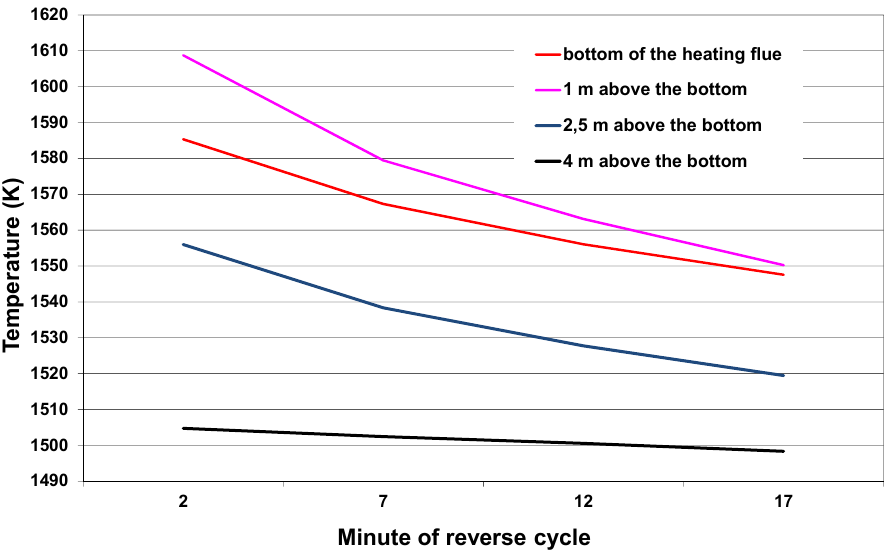
Figure 3. The exemplary temperature changes in the heating flues during the reverse cycle observed for PWR-63 battery.